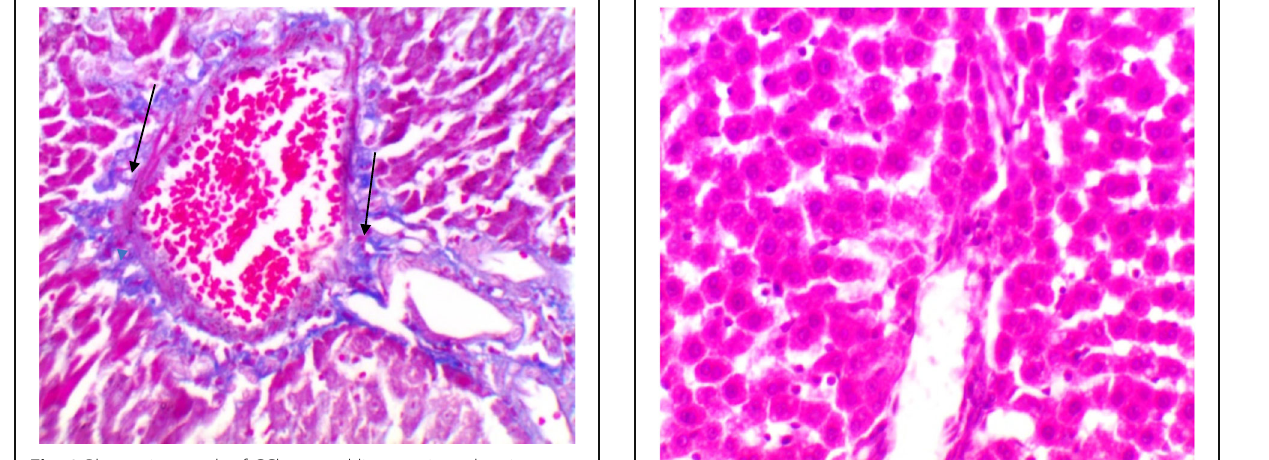
Fig. 8 Photomicrograph of CCl4-treated liver sections showing congested thickened portal tract with dense fibrous tissues radiating from the portal vein and extending into the parenchyma (Masson,s trichrome × 400)